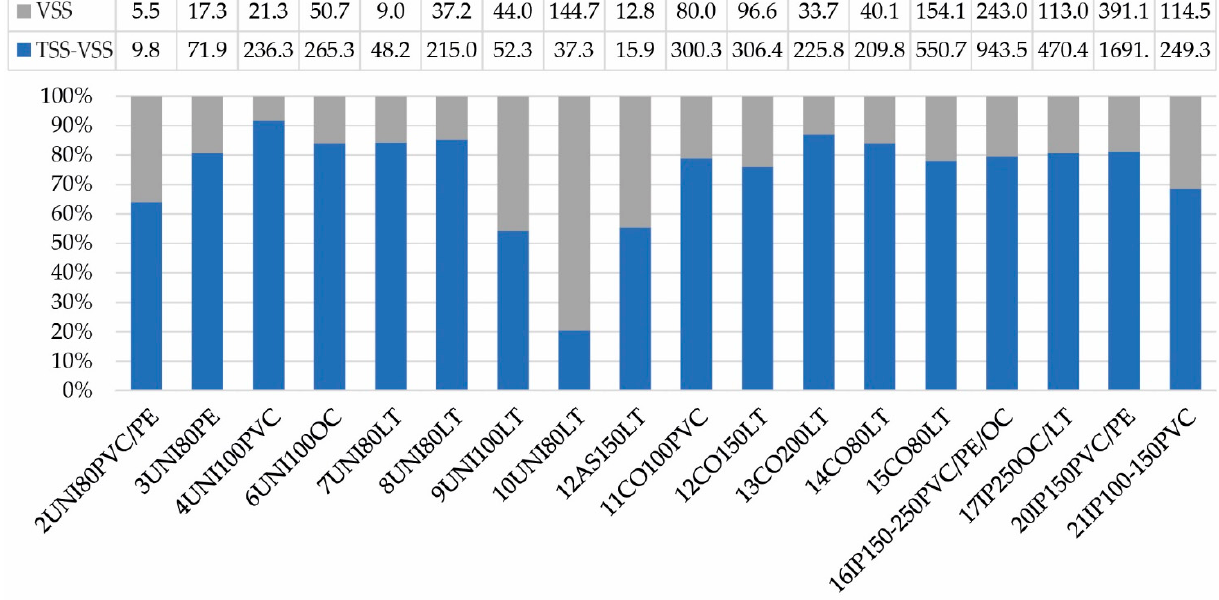
Figure 5. Ratio [%] of organic (VSS) and inorganic (TSS-VSS) material in solid phase of sediment estimated from the LOI 550 of the mass of measured total suspended solids. More data are not available. VSS—Volatile Suspended Solids in mg·L − 1 ; TSS-VSS—Residue on ignition in mg·L − 1 .